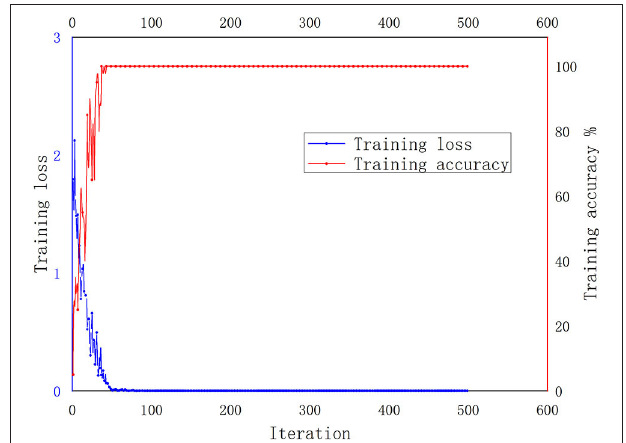
FIGURE 10 | The LeNet-5 method’s training accuracy and loss from the source task under a normal environment.